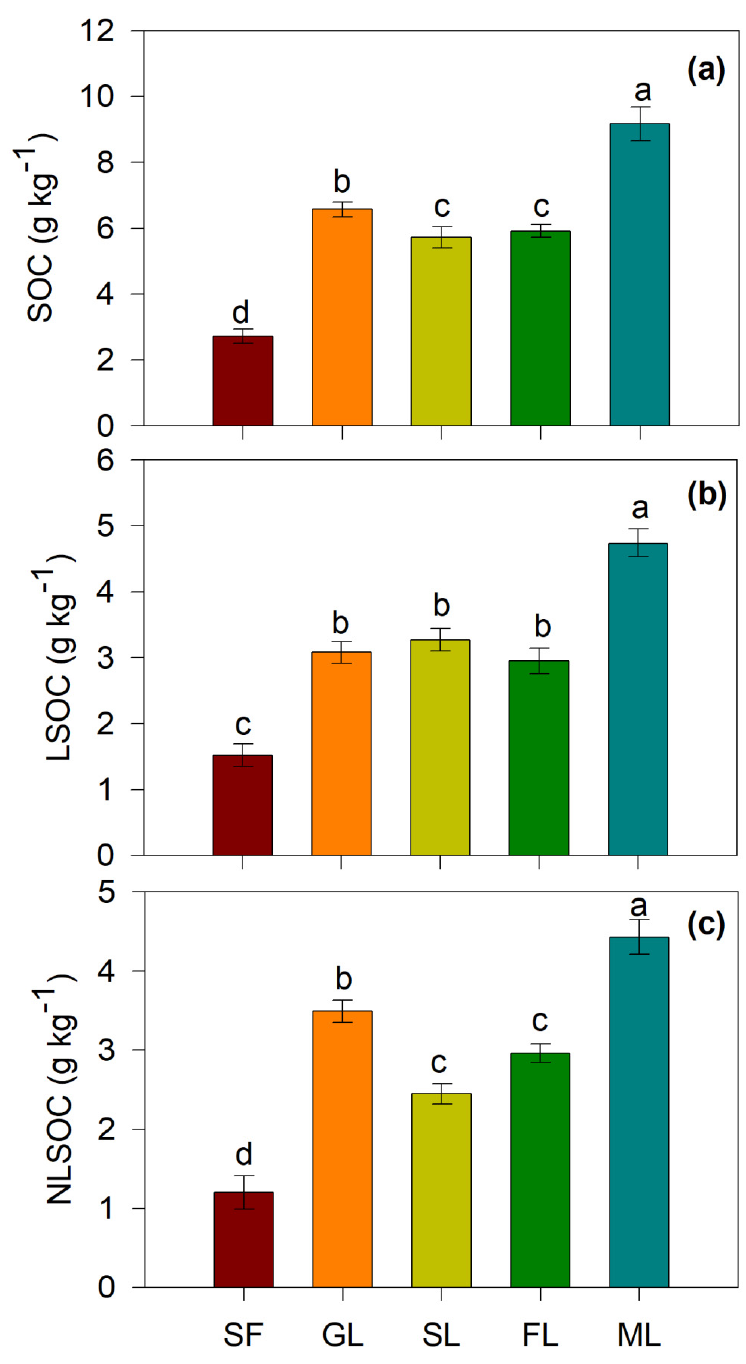
Figure 2. Soil organic carbon (SOC, ( a )), soil labile organic carbon (LSOC, ( b )) and Non-labile organic carbon (NLSOC, ( c )) in different vegetation restoration types. Note: SF, Sloping farmland; GL, Grassland; SL, shrubland of Caragana korshinskii ; FL, forestlands of Robinia pseudoacacia ; ML, mixed forests of Robinia pseudoacacia + Caragana korshinski . Different lower-case letters above the error bars indicate significant differences in different land use types at 0.05 level ( p < 0.05). Data are Means ± SE. n =